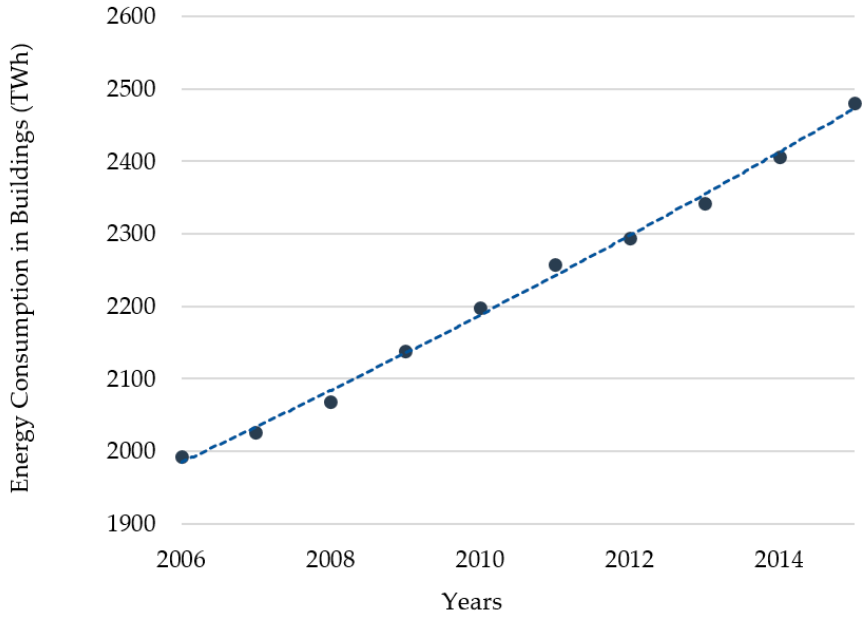
Figure 12. Building energy consumption in India, showing a +2.7% increase per year